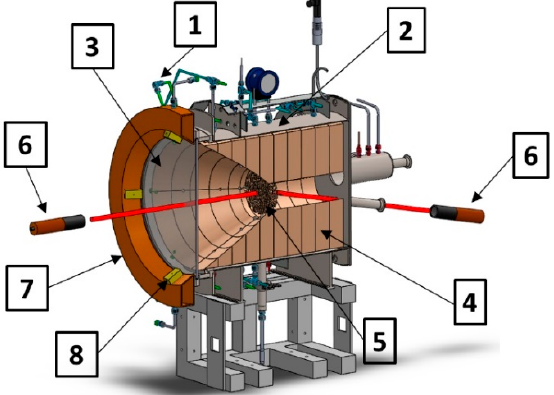
Figure 2. Reactor Cross-section. (1) Gas inlet manifold, (2) Reactor body, (3) Flat Glass Window, (4) Alumina thermal insulator, (5) Volumetric absorber, (6) Pyrometers, (7) Water-cooled aperture stop, (8) Window cooling nozzles.